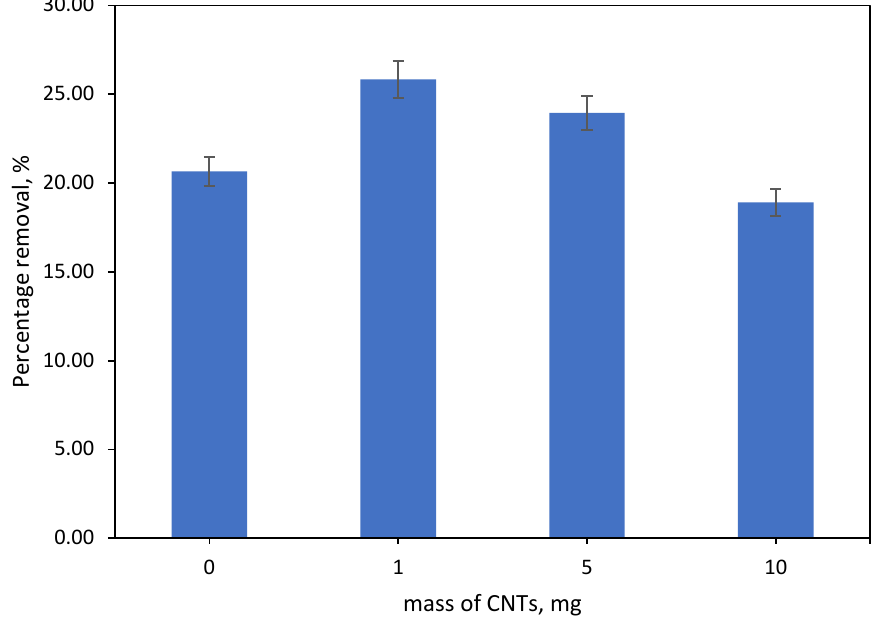
Figure 6. Effect mass of incorporated CNTs. Condition: [Ni(II)] = 10 mg/L, pH= 4, adsorbent dosage = 500 mg, contact time = 60 min.